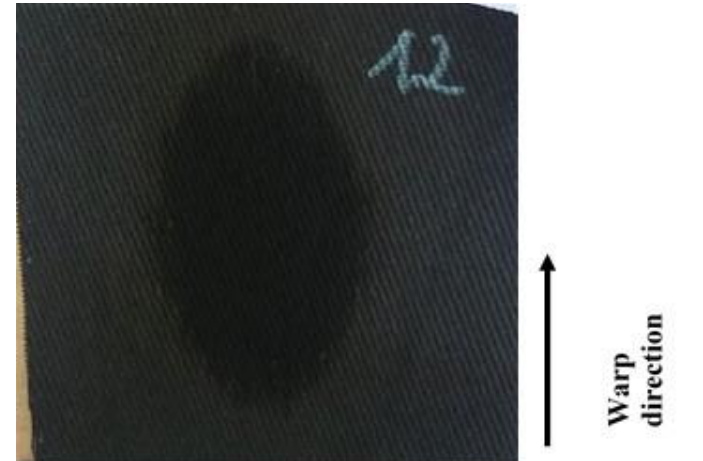
Figure 12. Exemplary picture of the investigated fabric after testing by means of the MMT.